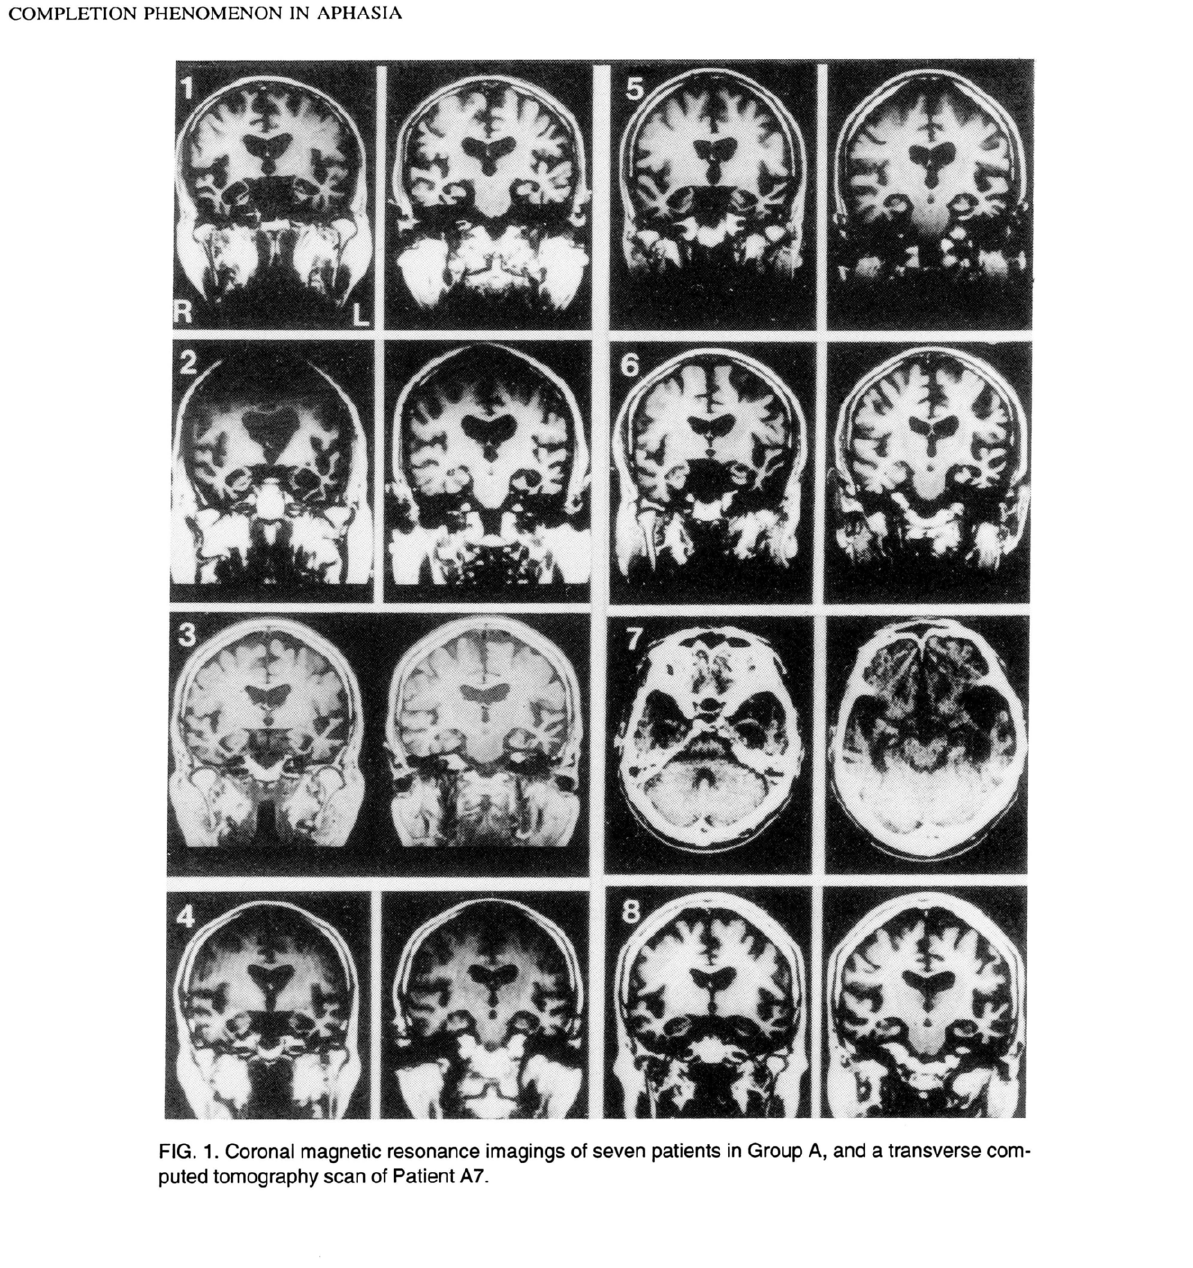
FIG. 1. Coronal magnetic resonance imagings of seven patients in Group A, and a transverse com puted tomography scan of Patient